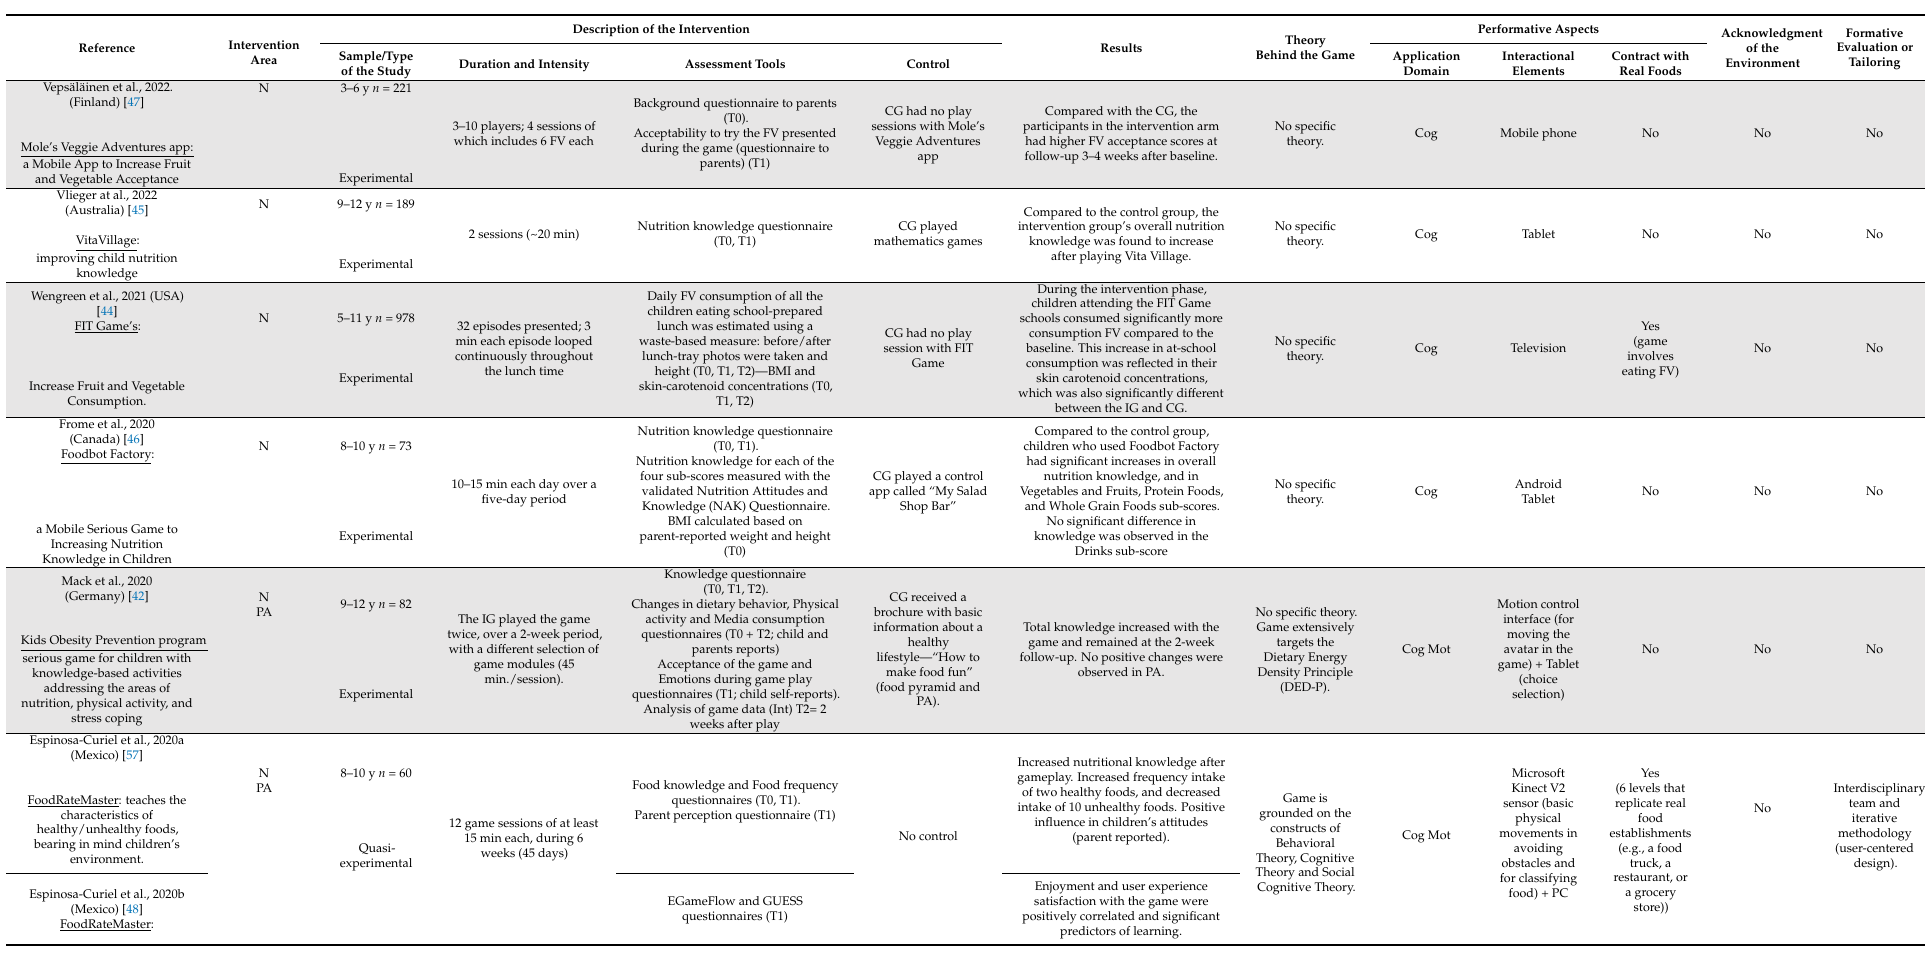
Table A1. Characteristics of the included